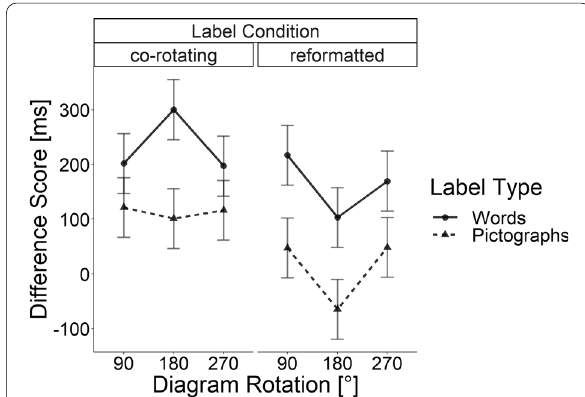
Fig. 6 Results of Experiment 2: Mean differences in response onset relative to the baseline without rotation. Error bars indicate Fisher’s Least Significant